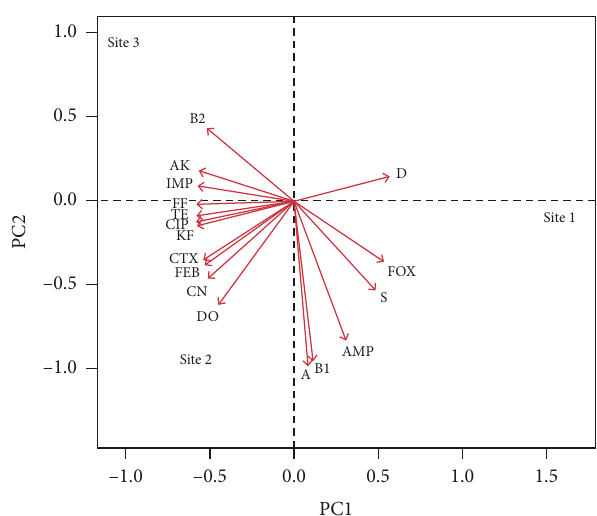
Figure 4: Principal component analysis biplot of the AR patterns of the E. coli phylogenetic groups from the three sampling sites along the Al-Hillah River. The red arrows indicate E. coli isolates resistant to 15 antibiotics with respect to their phylogenetic groups. Class